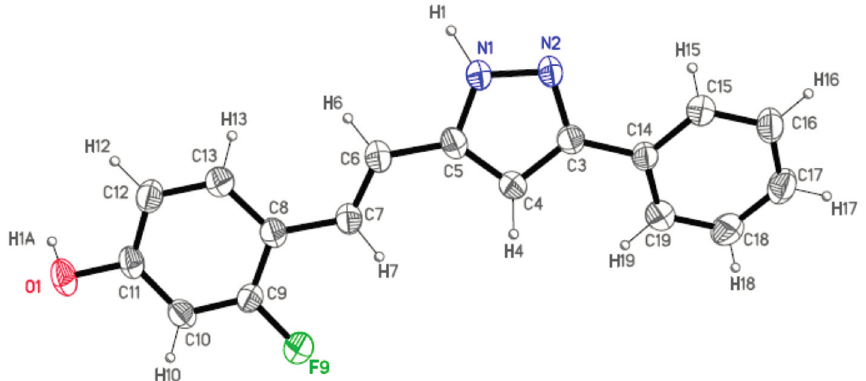
Figure 4. ORTEP (Oak Ridge Thermal Ellipsoid Plot) (40% ellipsoid probability) of 12 showing the labeling of the asymmetric unit.